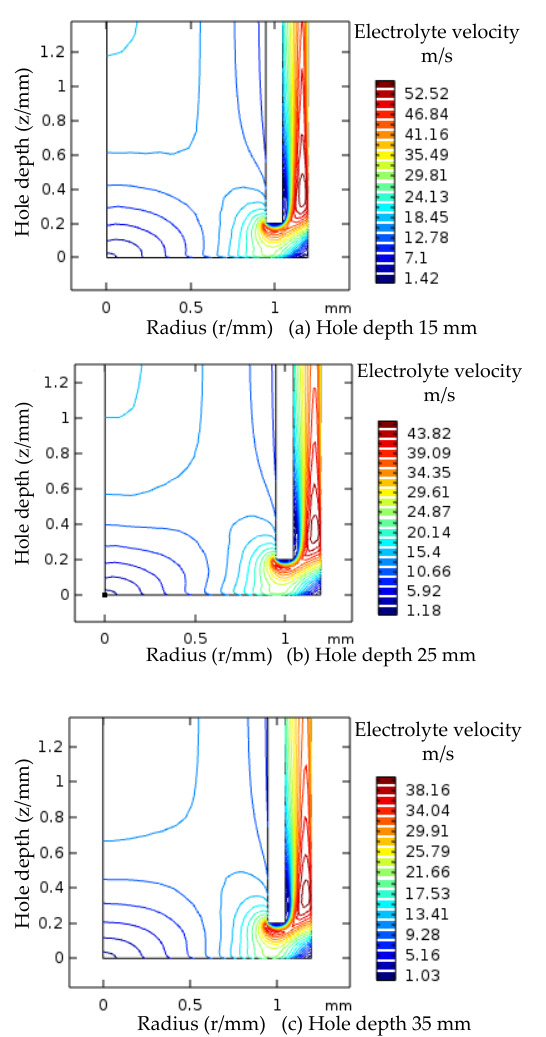
Figure 11. Velocity contour map of electrolyte low-speed region in the machining gap.